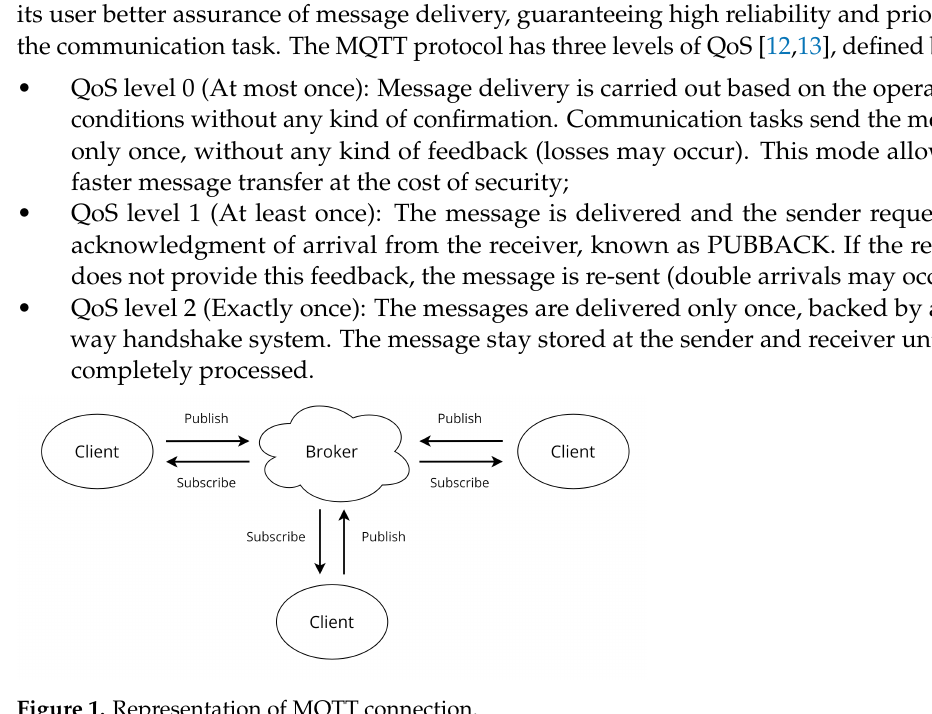
Figure 1. Representation of MQTT connection.